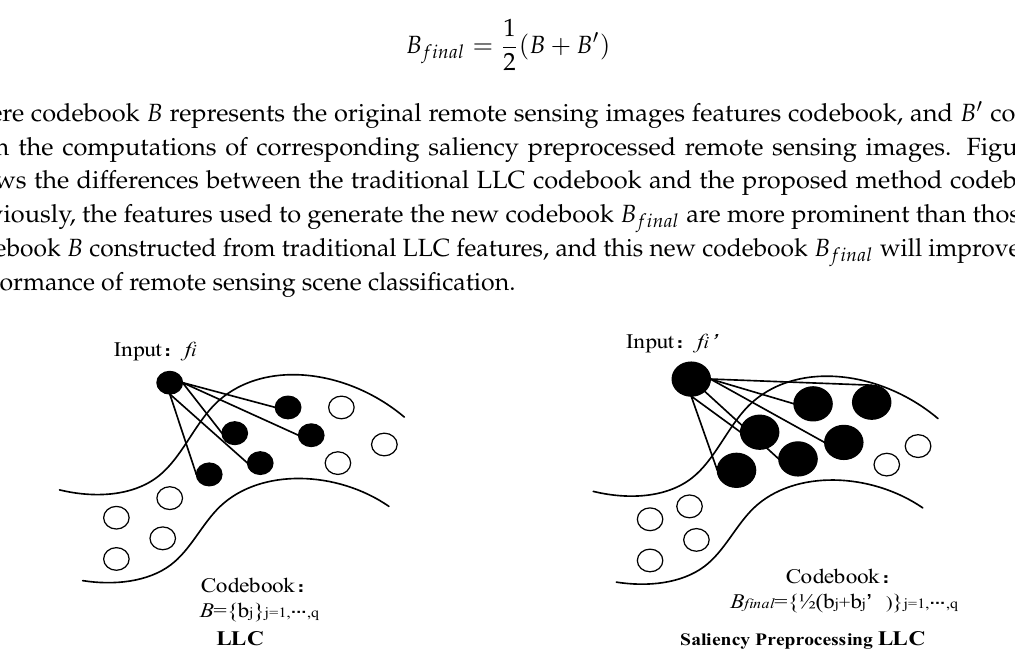
Figure 4. Comparison between LLC (Locality-constrained Linear Coding) and proposed method.